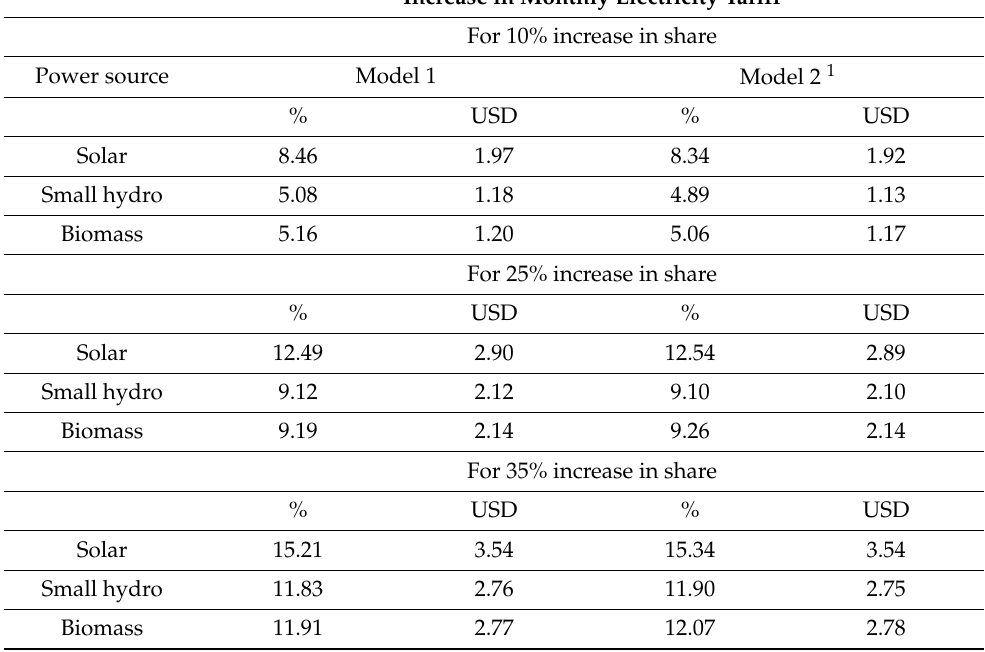
Table 6. WTP by source and